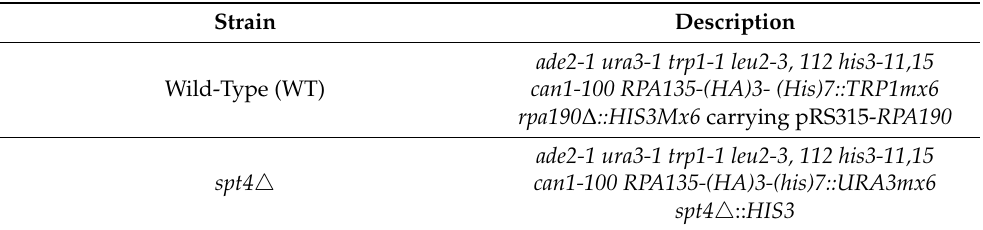
Table 1. Description of strains used for NET-seq